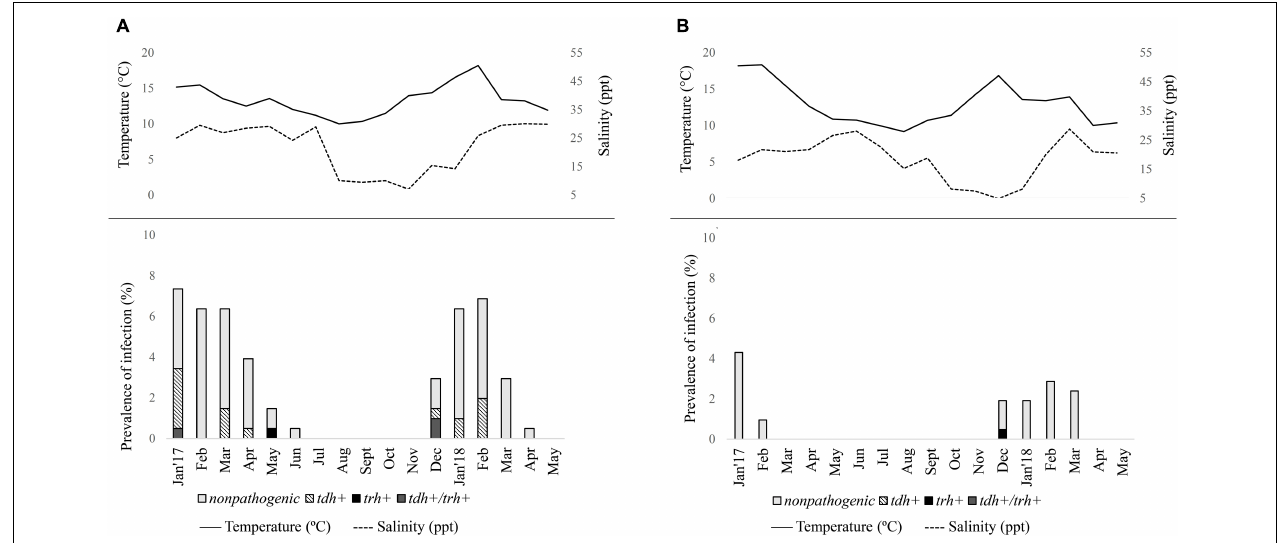
FIGURE 3 | Seasonal distribution of total and pathogenic Vibrio parahaemolyticus in Mytilus chilensis from January 2017 to May 2018 in (A) Valdivia River Estuary and (B) Reloncaví Fjord of southern Chile. Each line or bar represents the arithmetic mean of three points. Solid line represents seawater temperature ( ◦ C); dashed line represents salinity (ppt) during each campaign.